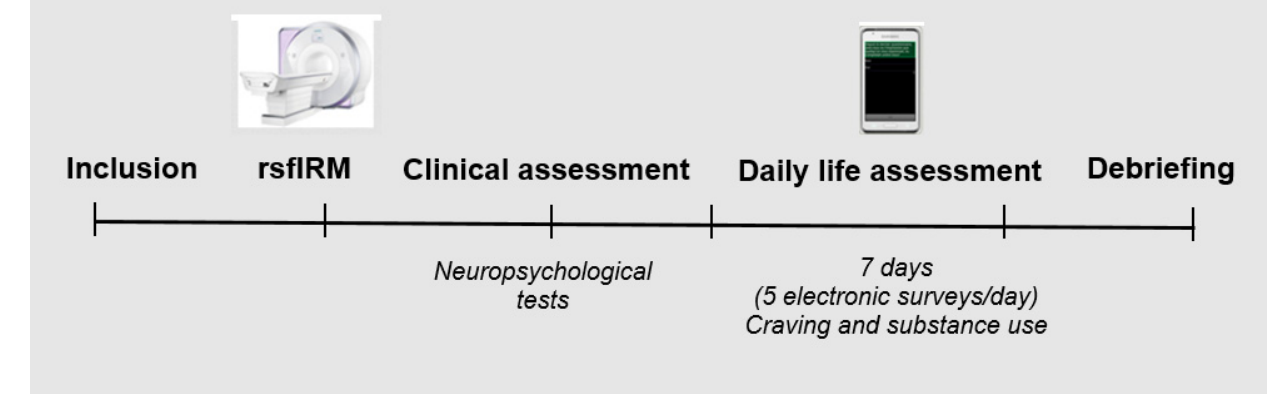
Figure 1. Overview of the method and procedures of the